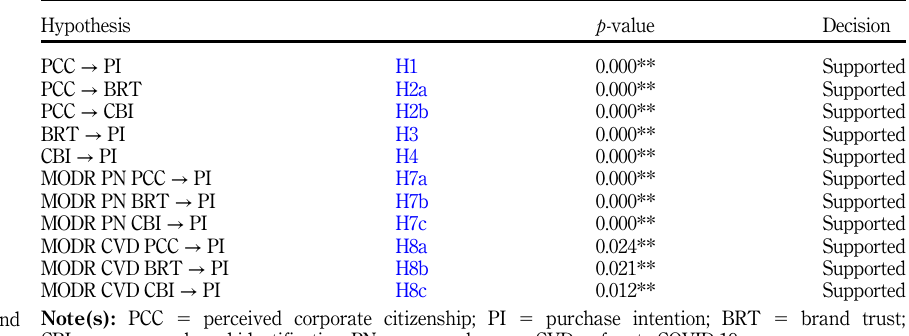
regression weight and p